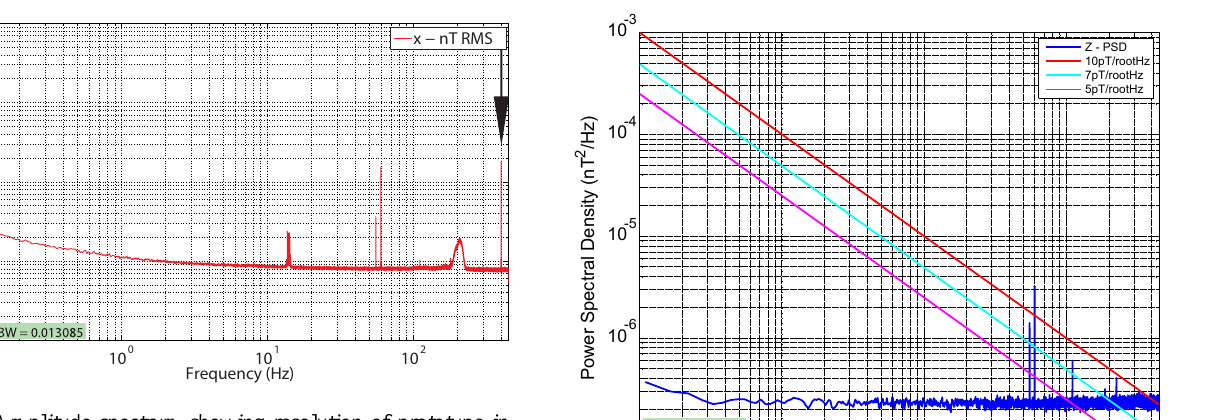
Fig. 11. Amplitude spectrum showing resolution of prototype in- strument. Arrow shows an 18pT RMS sinusoidal test signal at 400Hz.